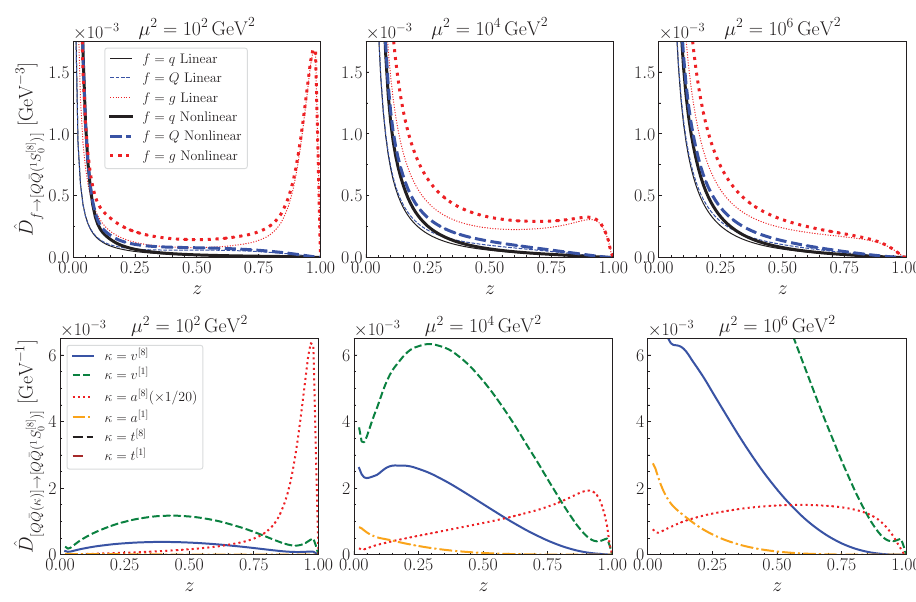
Figure 2. The single and double parton FFs for producing a heavy quark pair in the intermediate = ( 4 m ) 2 with m = 1.5GeV up to given values of state 1 S [ 8 ] as functions of z , evolved from μ 2 c c 0 0 μ 2 : μ 2 = 10 2 GeV 2 (left column), μ 2 = 10 4 GeV 2 (middle column), μ 2 = 10 6 GeV 2 (right column). = D / 〈(cid:4) 〉 with 〈(cid:4) 〉 the LDME for the production of a quark pair in κ . The single parton FFs ˆ D κ κ κ κ with the linear (thin) and nonlinear (thick) evolution differ in line width in each panel. Black solid curves: light quarks ( u , d , s ), Blue dashed curves: heavy quarks ( c ), Red dotted curves: gluon.